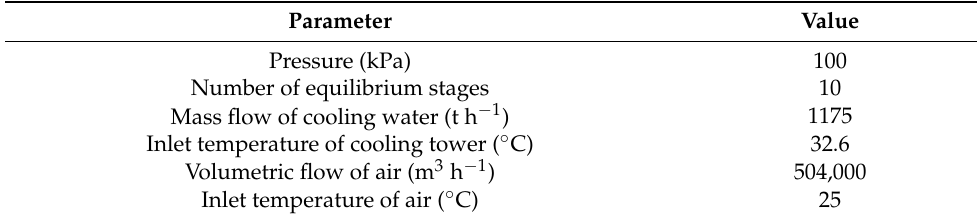
Table A7. Parameters of cooling towers used for modeling in Aspen Plus.